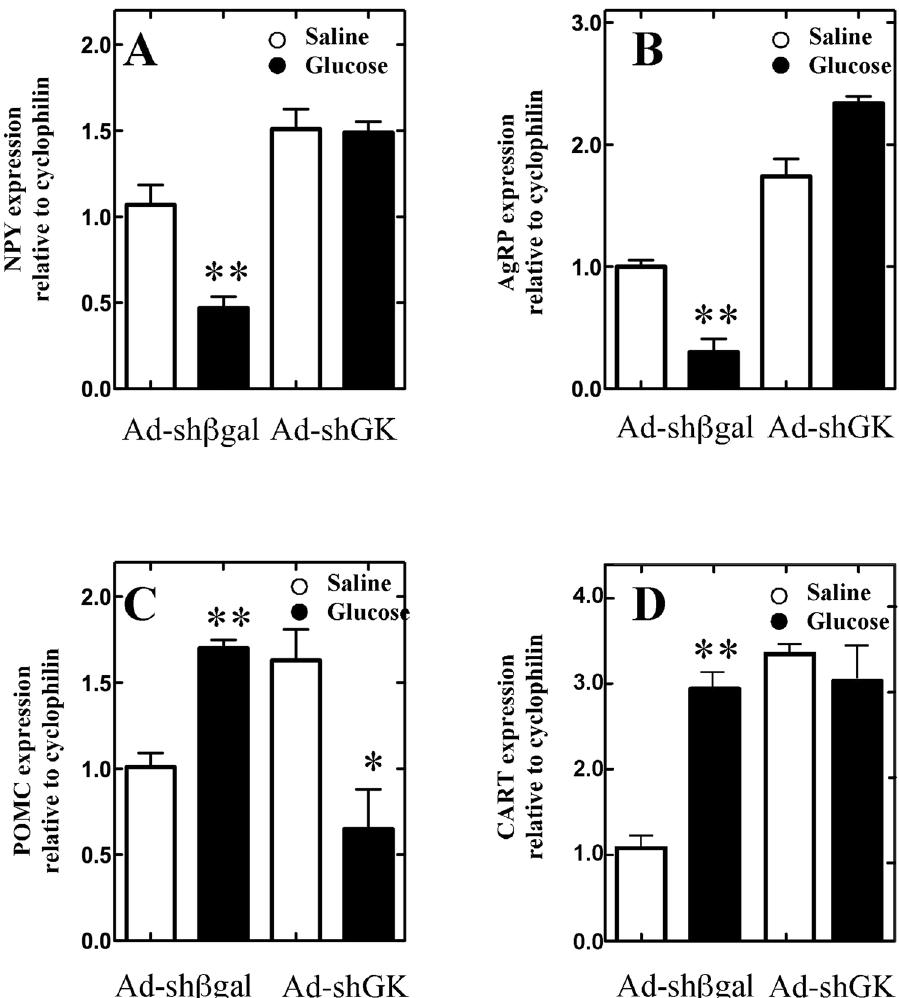
Figure 5. Expression of neuropeptides involved in feeding regulation. ( A–D ) Control (Ad-sh β Gal-EGFP- injected animals) and AdshGK-injected animals (Ad-shGK) were subjected to a 24-h fasting period. After that, saline or D-glucose was injected into the 3 V. After 2 h, NPY ( A ), AgRP ( B ), POMC ( C ) and CART ( D ) mRNA levels were assessed via qRT-PCR. Data are relative to cyclophilin (media ± SEM; n = 6) and processed by the ΔΔ CT method. Statistics: Non-parametric ANOVA; * p <